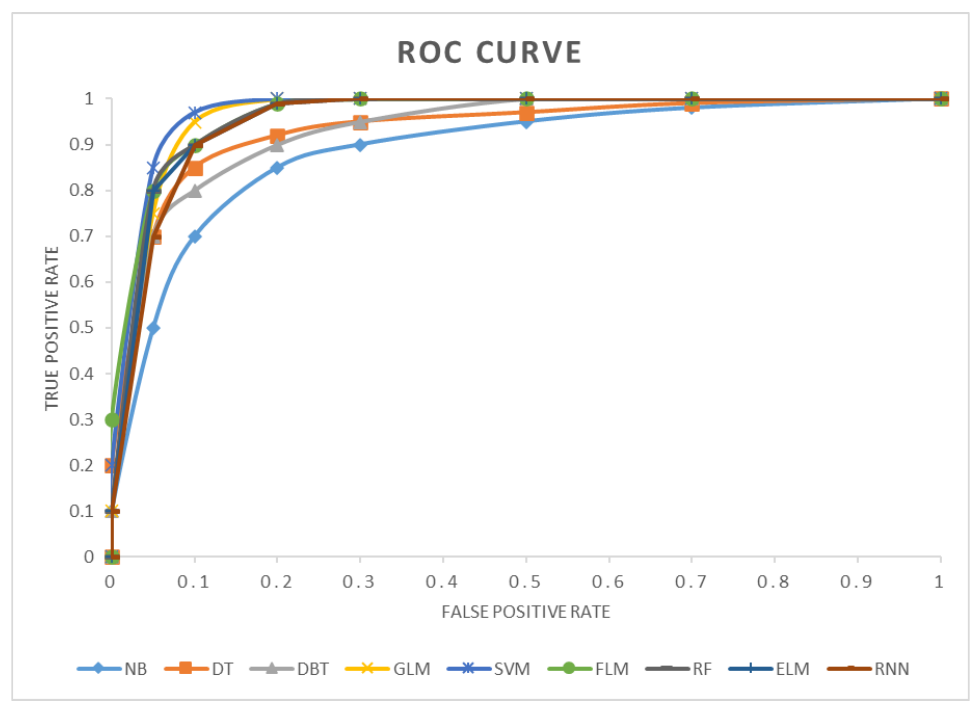
Figure 7. RoC Curves depicting the performance of the algorithms in terms of True positive rate.